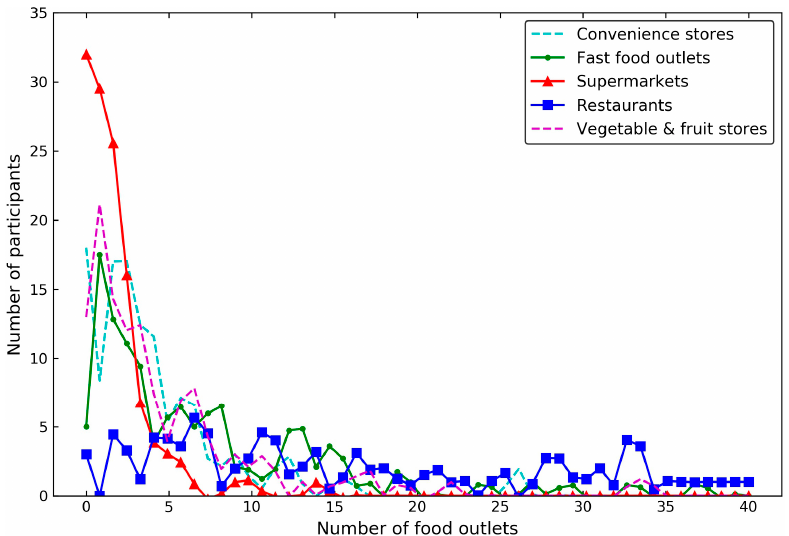
Figure 10. The overall food outlet distributions by food outlet types based on TWE ‐ TC.